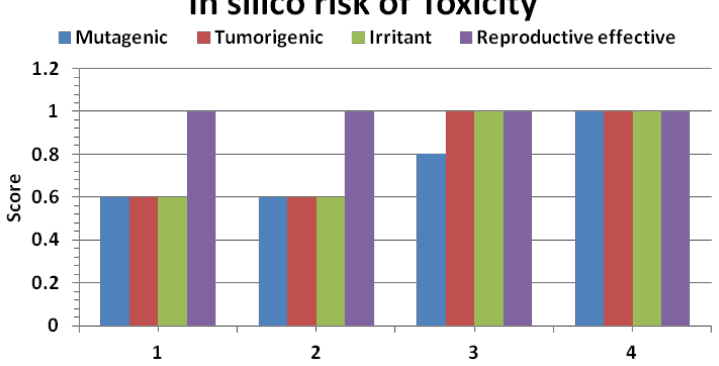
Figure 7. In silico drug safety analysis for ILs by the Osiris software. High score is an indicator of safe drugs (Score 1 is a highly safe drug